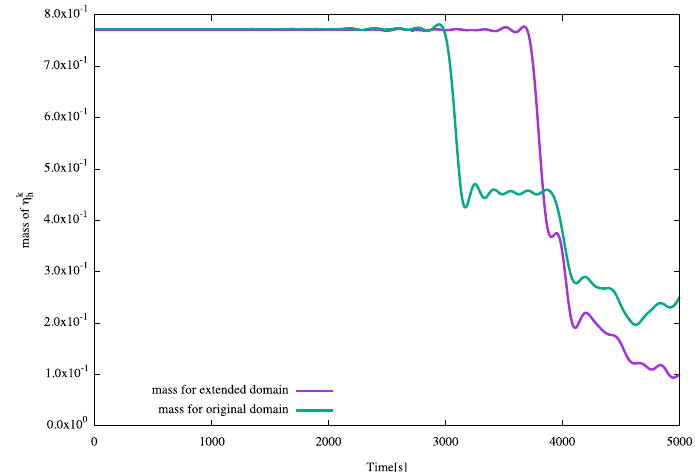
Figure 15. Graphs of the mass of η n